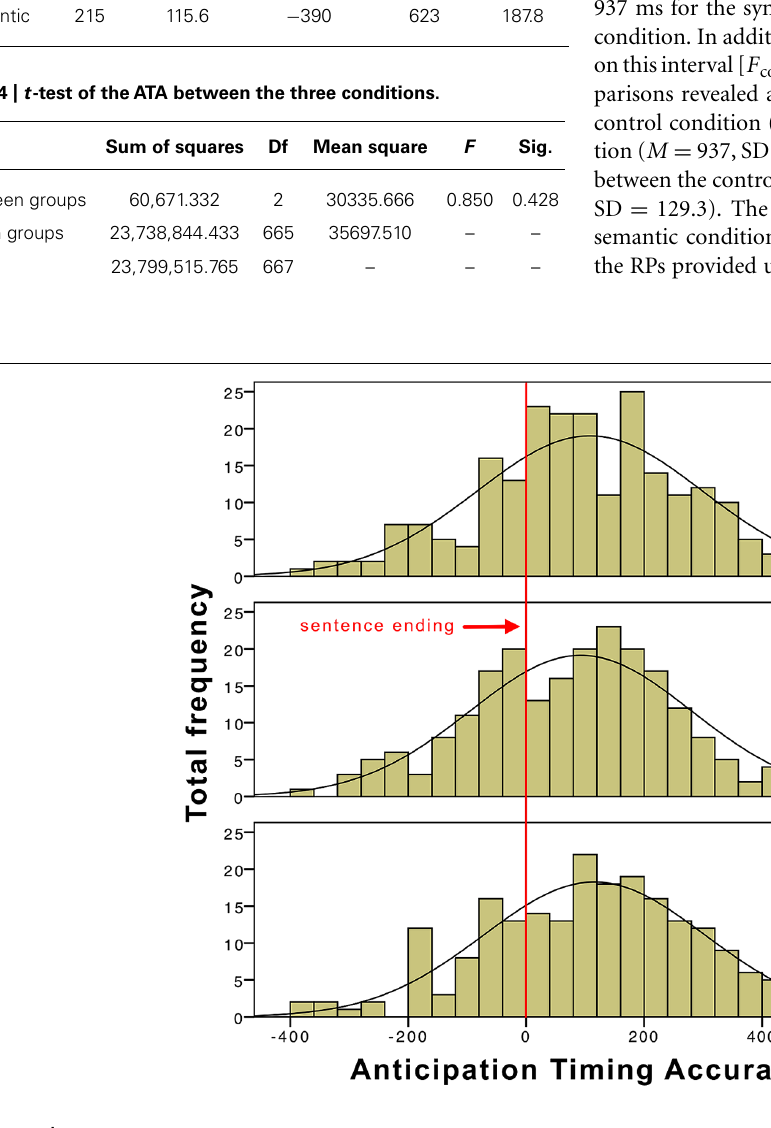
Frontiers in Human